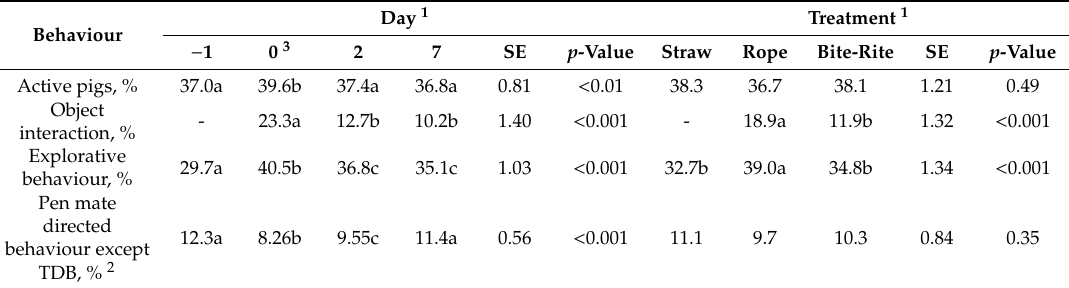
Table 5. The frequency of behaviours (percentage of pigs) observed on day − 1, 0, 2, and 7 and within each treatment (straw, rope and Bite-Rite). Different lowercase letters (a, b and c) indicate significant difference of p < 0.05 between days or between enrichment treatment.